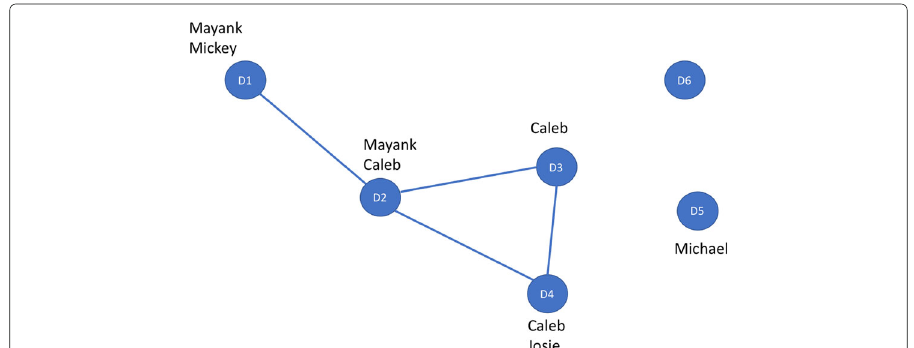
Fig. 2 An example of an Attribute Extraction Network (AEN), assuming the attribute Name . Vertices are documents. D6 and D5 are singletons since D5 does not share extractions with any other document, and D6 does not have any